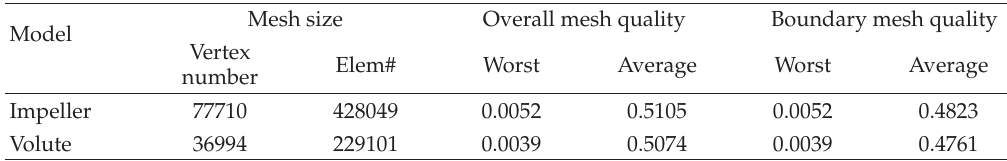
Figure 6: Time for di ff erent weight coe ffi cients. Table 1: Statistics of the examples before